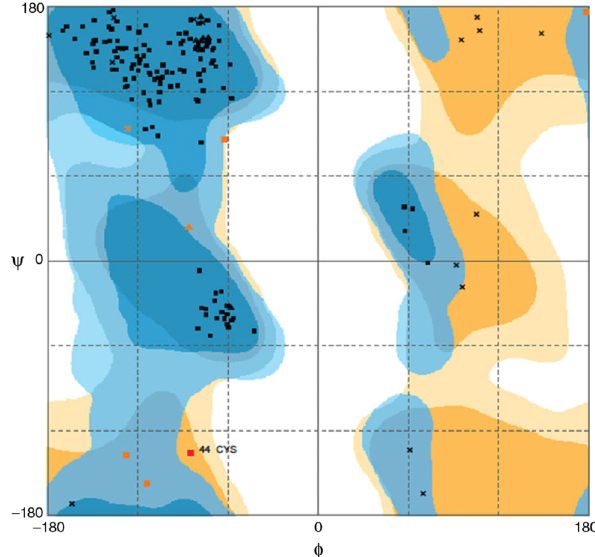
Figure 6: Ramachandran plot analysis for the predicted structure. It was observed that about 157 (95.7%) amino acids are in favourable regions. The total number of residues in the allowed region are 6 (3.7%). The total number of residues outlier region is 1 (0.6%).